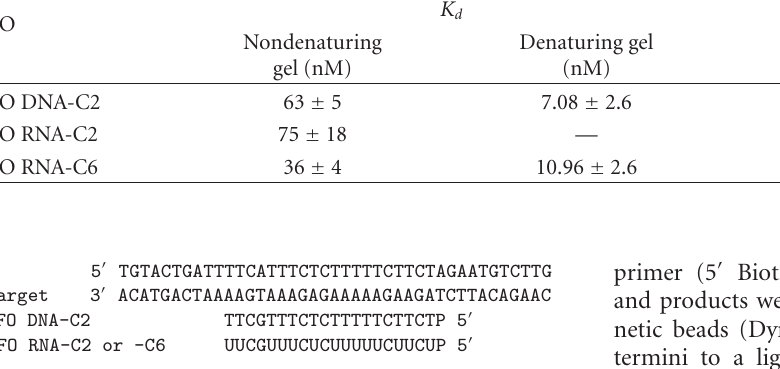
Figure 1: TFO and target DNA sequences. TFOs composed of either DNA or 2 (cid:2) - O -methyl RNA are depicted. P represents HMT conjugated to the TFO by either a 2- or 6-carbon